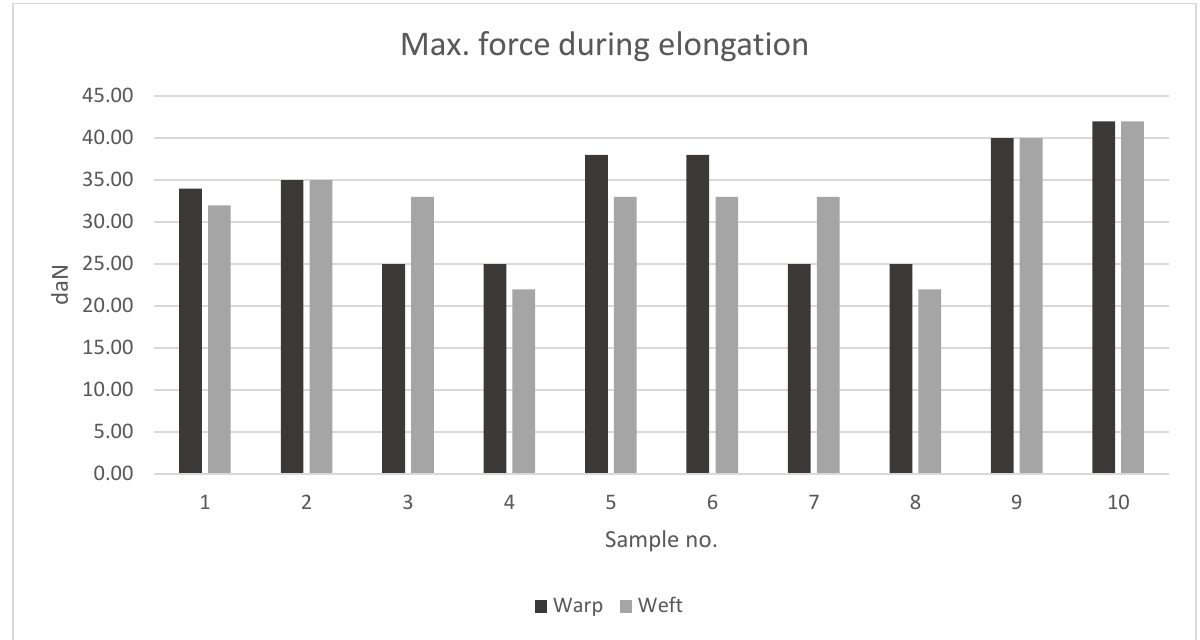
Figure 4. Obtained values of the breaking force during the tensile tests.